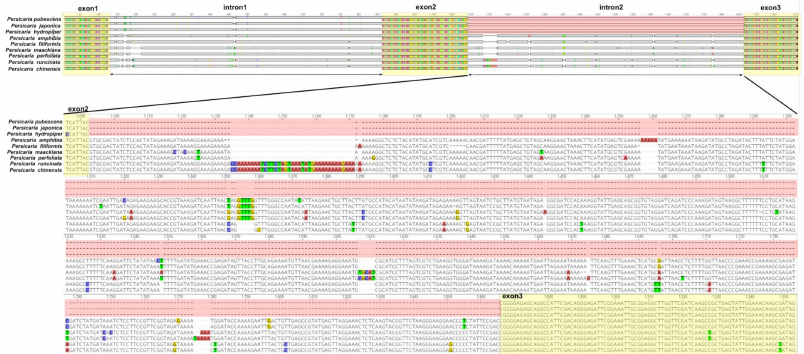
Figure 2. The sequences of ycf3 gene among nine Persicaria species. The yellow boxes indicate the exon and red boxes indicate the loss of ycf3 intron